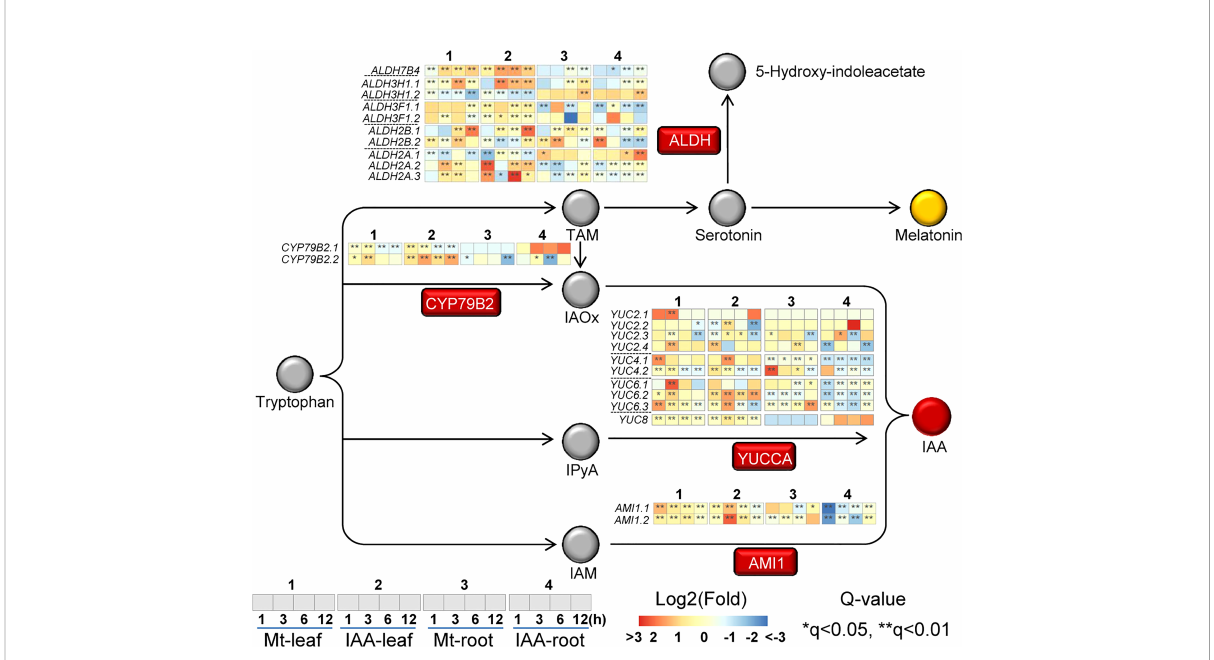
FIGURE 4 Expression changes of genes related to auxin biosynthesis. The rectangles indicate the enzymes related to melatonin/auxin biosynthesis pathway, while the circles indicate the precursors/metabolites. Italic indicates the gene that may encode the enzyme. Heat-maps indicate expression changes at a time point, while asterisks indicate signi fi cant change, compared to the untreated samples (0 h). Asterisks indicate signi fi cant differences (*q < 0.05 and **q < 0.01) compared to the untreated samples (0